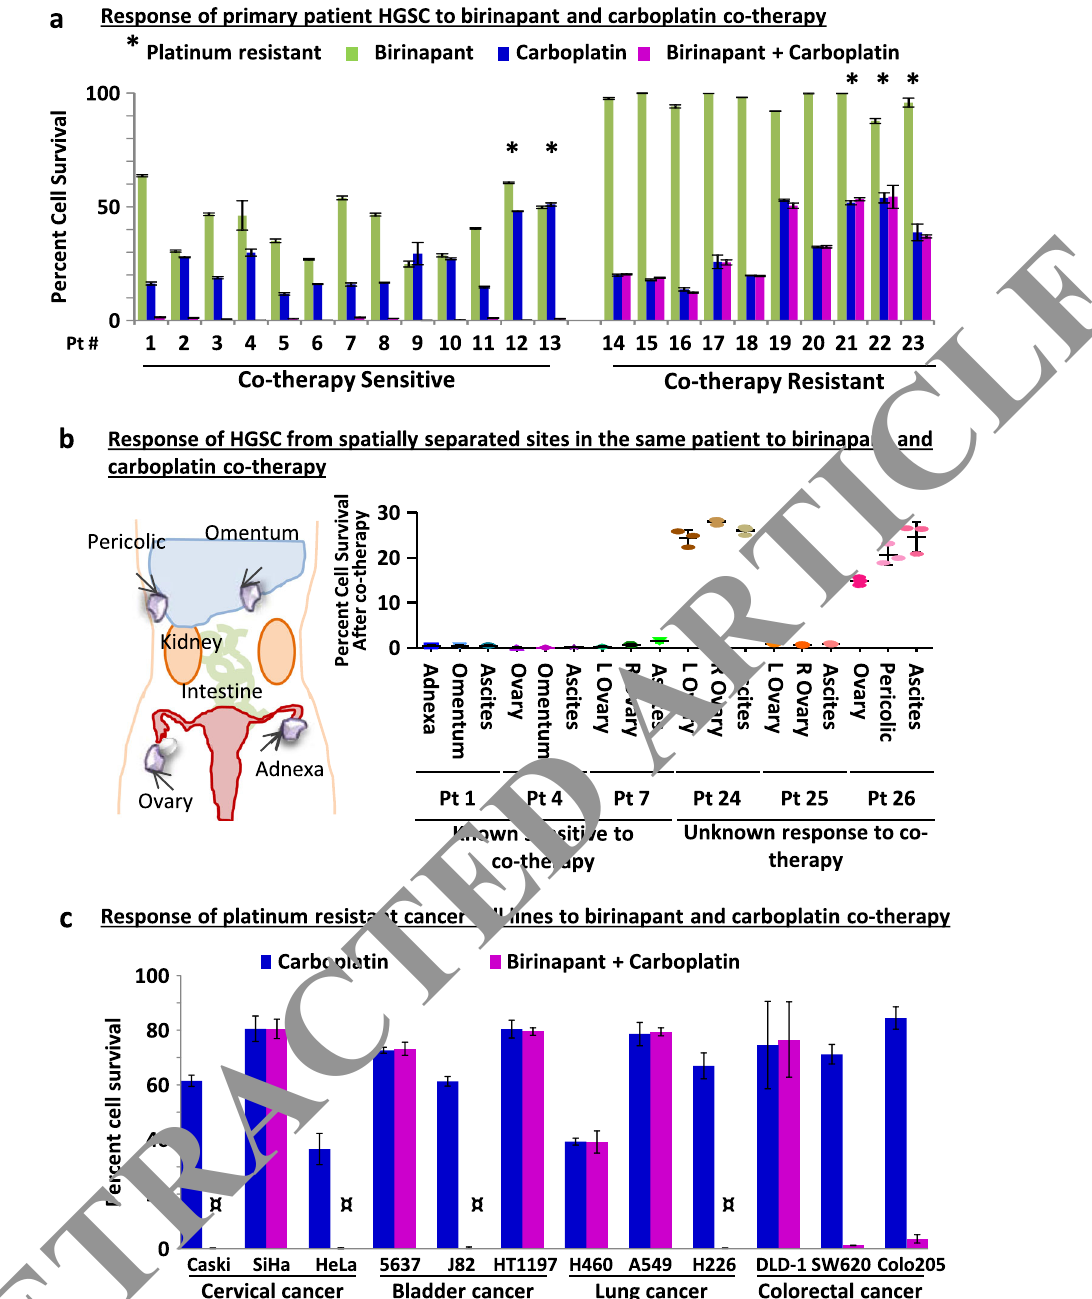
Fig. 2 Half of HGSC and non-HGSC carcinomas tested were sensitive to carboplatin and birinapant co-therapy. a Assessment of cell survival after drug treatment in the in vitro organoid bioassay ( n = 3 replicates/specimen) revealed that in a cohort of 23 randomly selected primary patient HGSC specimens 13 were sensitive to co-therapy, while 10 were resistant. Single asterisk denotes samples clinically de fi ned as platinum resistant. b Analysis of matched tumor specimens (three replicates/specimen) collected from spatially separated sites in the same patient ( n